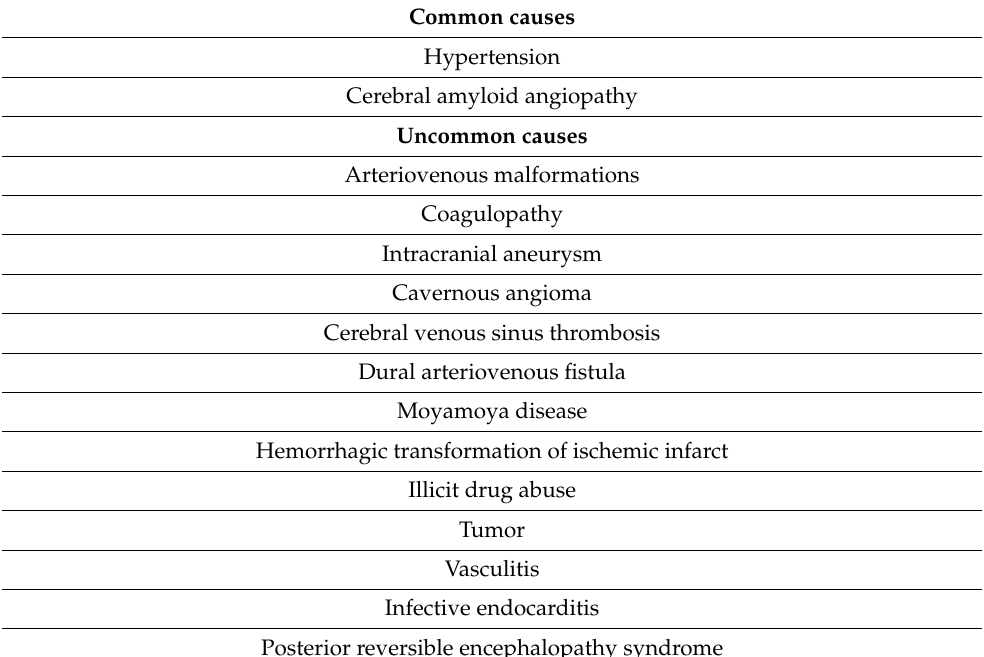
Table 1. Common and uncommon causes of